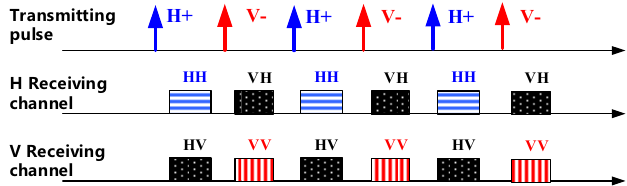
Figure 2. GF-3 time-division operation architecture with inverse modulation slopes.